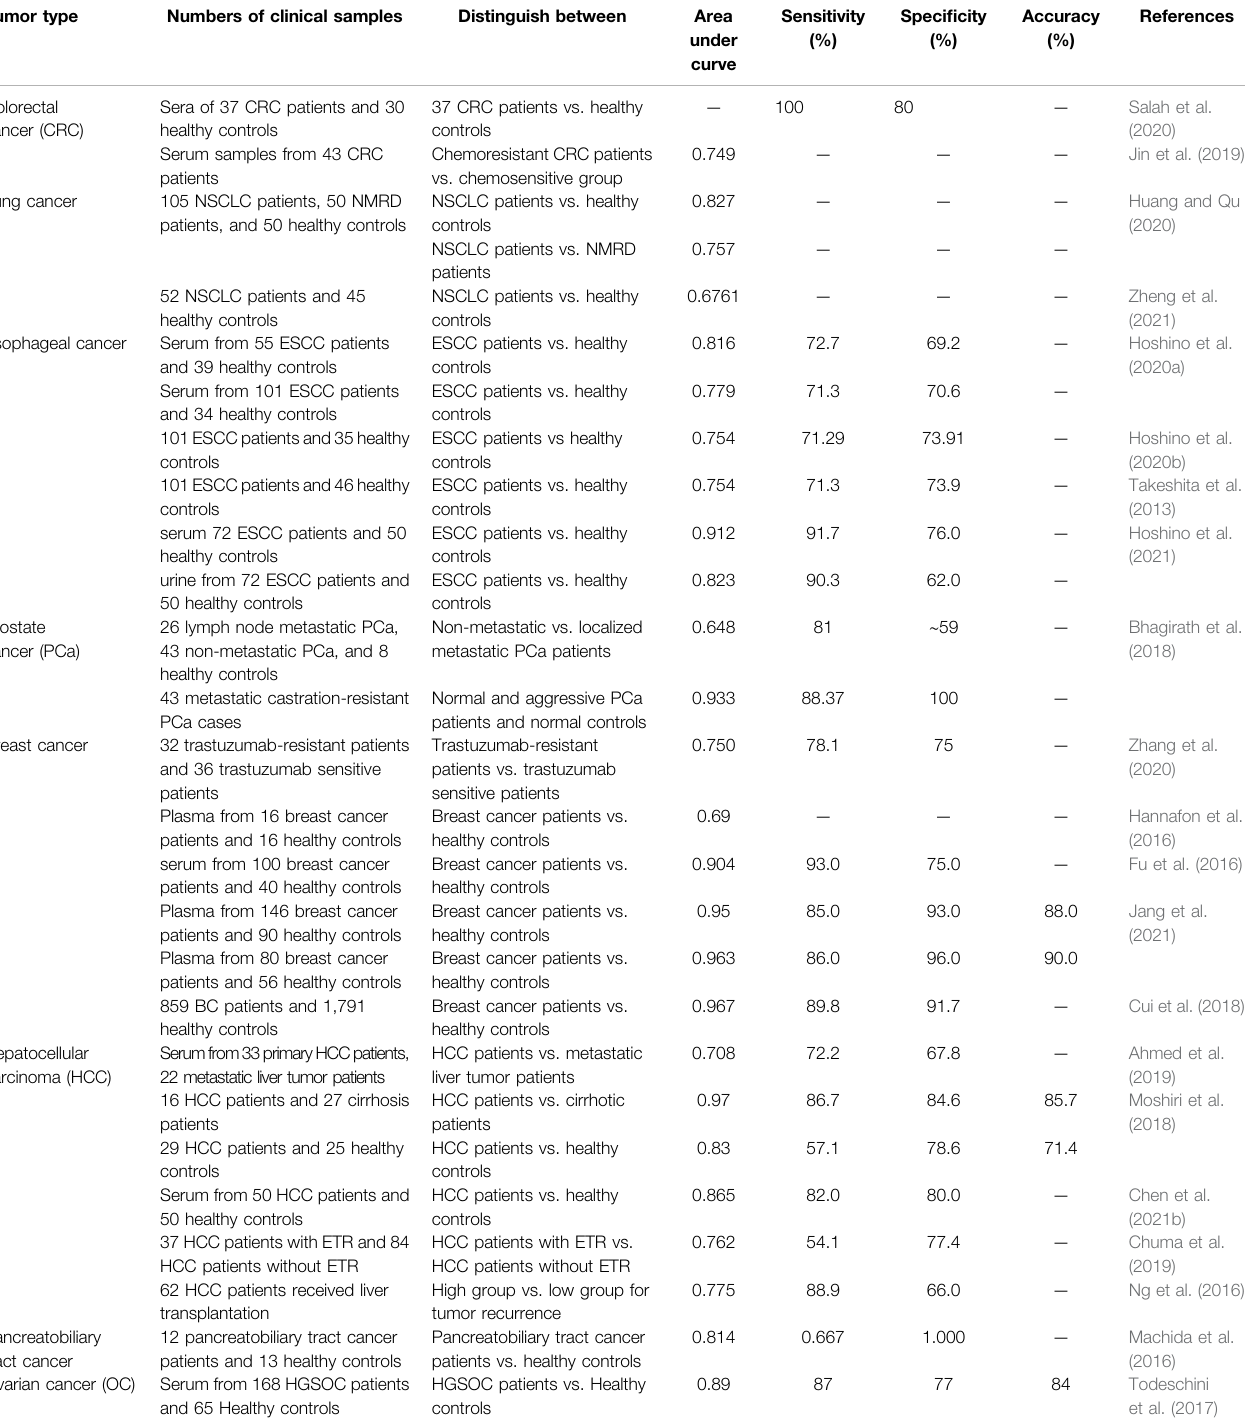
TABLE 4 | Diagnostic value of miR-1246 in cancers (NMRD: non-malignant respiratory diseases, NSCLC: non-small cell lung cancer, ESCC: esophageal squamous cell carcinoma, ETR: Early tumor recurrence, HGSOC: High-grade serous ovarian carcinoma).